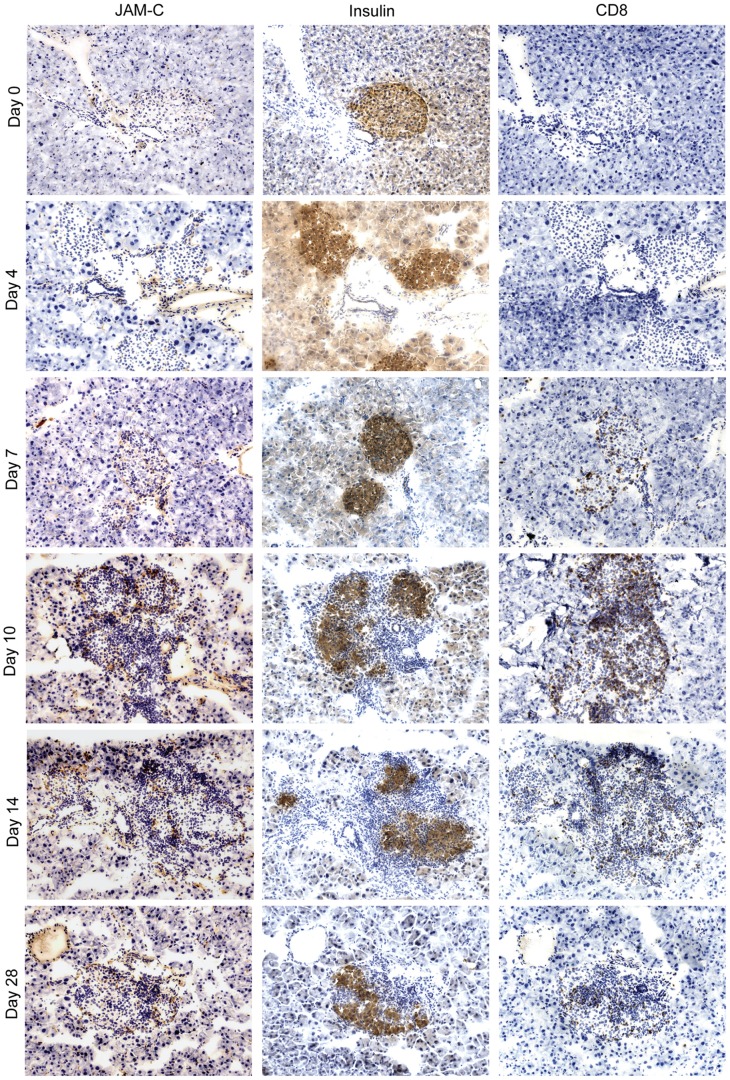
JAM-C expression correlates with islet infiltration and functional impairment.- Pancreas sections of RIP-LCMV-GP mice were probed for JAM-C expression, insulin production and CD8+ T cell infiltrations at different times after LCMV-infection.